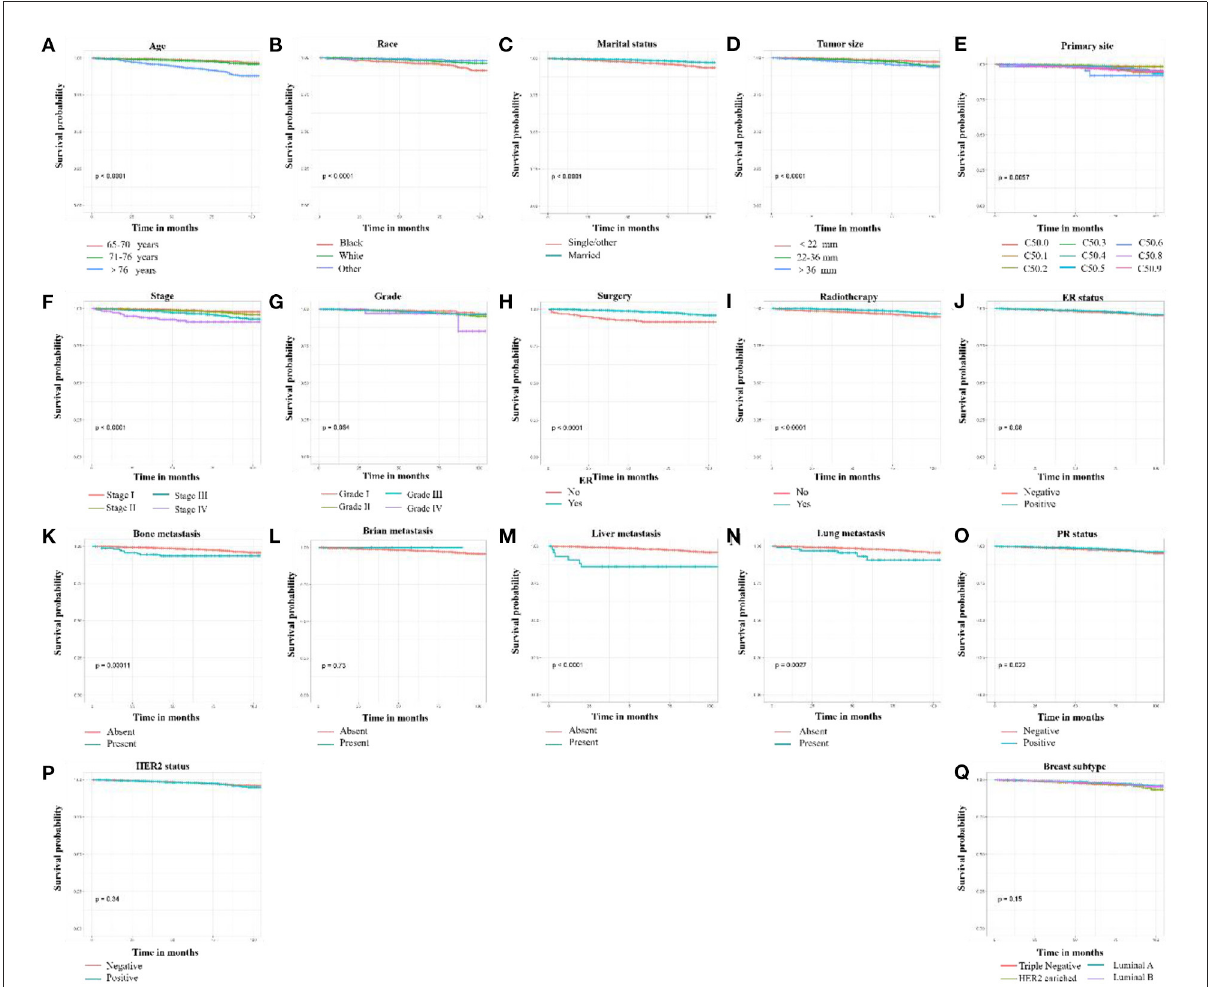
FIGURE1 Kaplan-Meier curves of HDSS-related variables in older female primary breast cancer patients that underwent chemotherapy. (A) age, (B) race, (C) marital status, (D) tumor size, (E) primary site, (F) tumor stage, (G) tumor grade, (H) surgery, (I) radiotherapy, (J) ER status, (K) bone metastasis, (L) brain metastasis, (M) liver metastasis, (N) lung metastasis, (O) PR status, (P) HER2 status, and (Q) breast subtype.